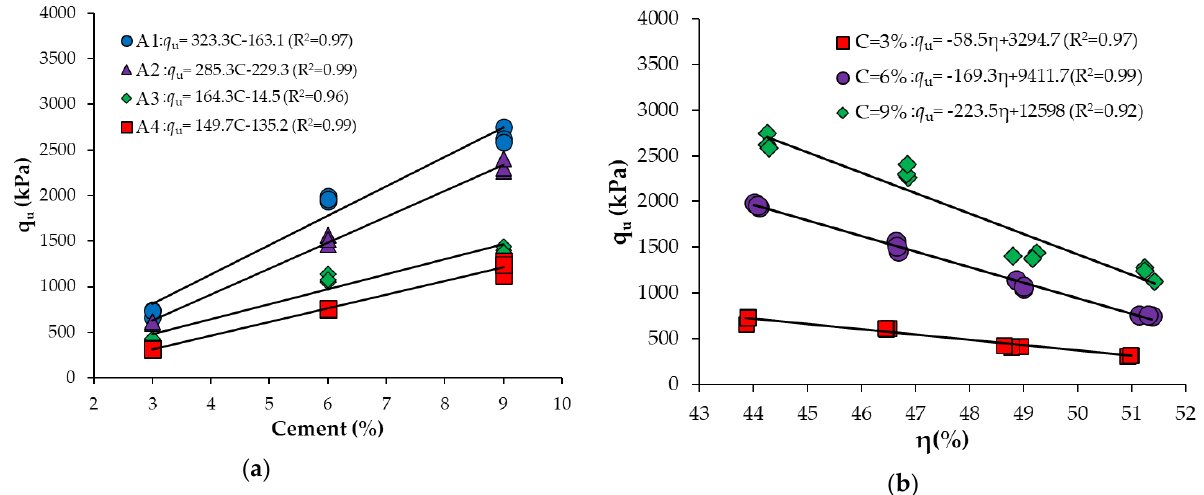
Figure 5 . ( a ) Influence of cement percentages on the q u for 15% roof tile waste; and ( b ) Influence of the porosity on the q u for 15% roof tile waste